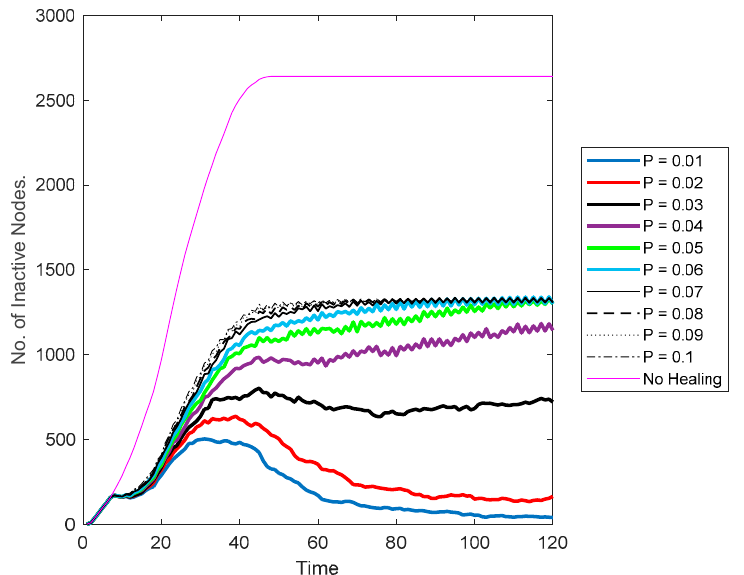
Figure 6. The number of inactive nodes as a function of time under load-based failures with deferent P values. In all cases, α = 1, RP = 0.8, T = 0.05, number of initial attack nodes = 8.